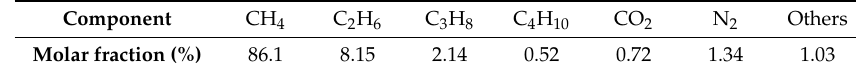
Figure 2. Calcium Looping system (a) coupled to a coal-fired thermoelectric plant, and; (b) coupled to 239